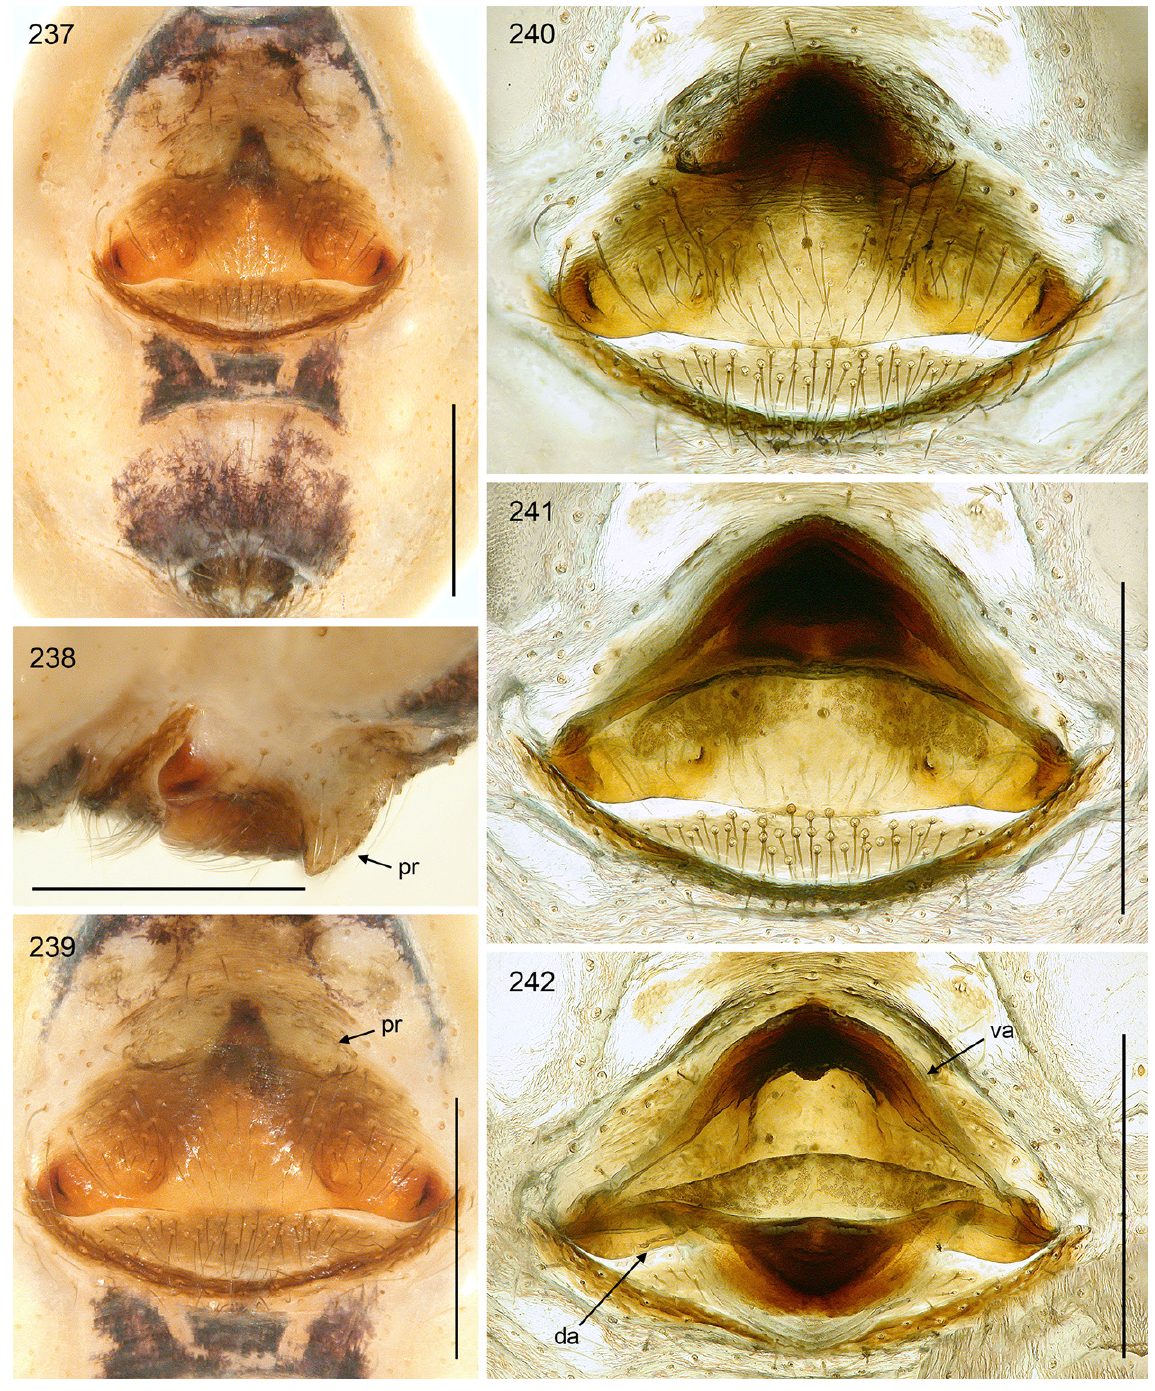
Figs 237–242. Maghreba stifadma gen. et sp. nov.; female from Morocco, Setti-Fatma (ZFMK Ar 22369). 237 . Abdomen, ventral view. 238–239 . Epigynum, lateral and ventral views. 240–242 . Cleared female genitalia, ventral view, regular dorsal view, and dorsal view with dorsal arc tilted backwards. Abbreviations: da = dorsal arc; pr = epigynal process; va = ventral arc. Scale bars = 0.5